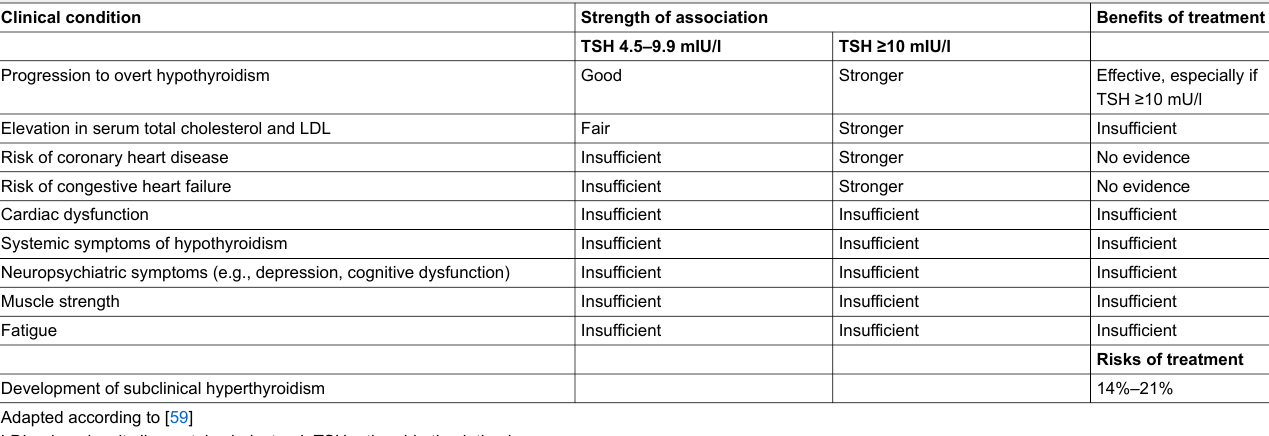
Table 1: Level of evidence in 2014 on the risks of treatment and the benefits of subclinical hypothyroidism. Clinical